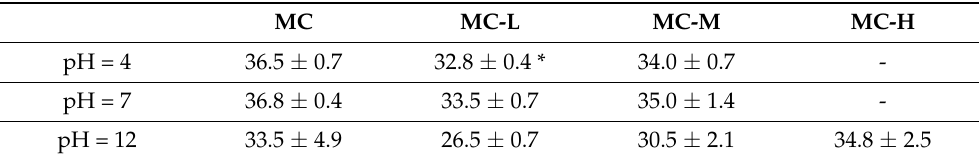
Table 1. T t calculated from temperature sweep tests for each MC hydrogel formulation. * = p < 0.05 compared with MC